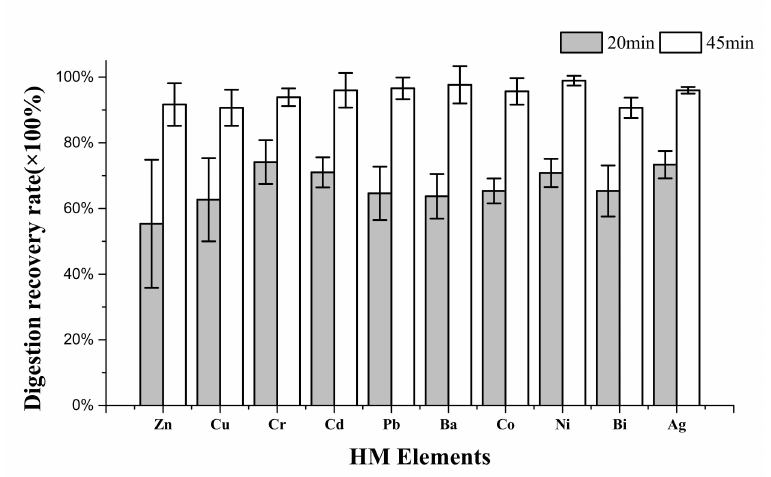
Figure 4. UAEO standard digestion rate of 10 primary HMs in dairy